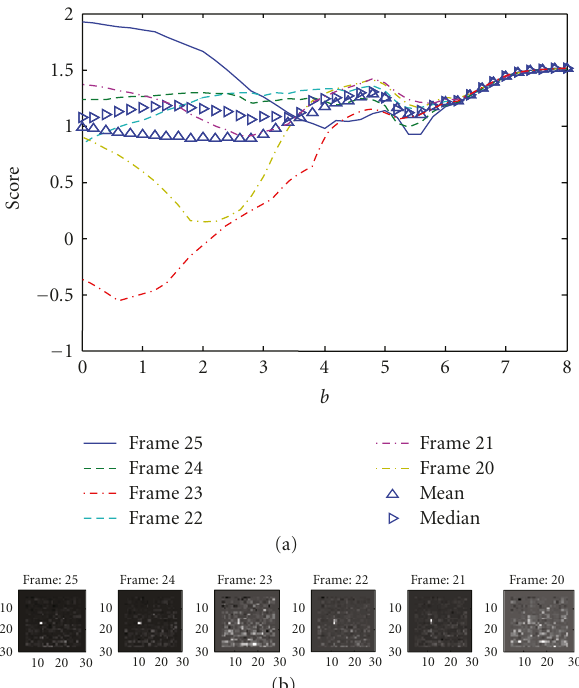
Figure 9: NA23A sequence preliminary results; g = 0, Max Numbers = 5. (a) A S for b = [0 ··· 8], and six last